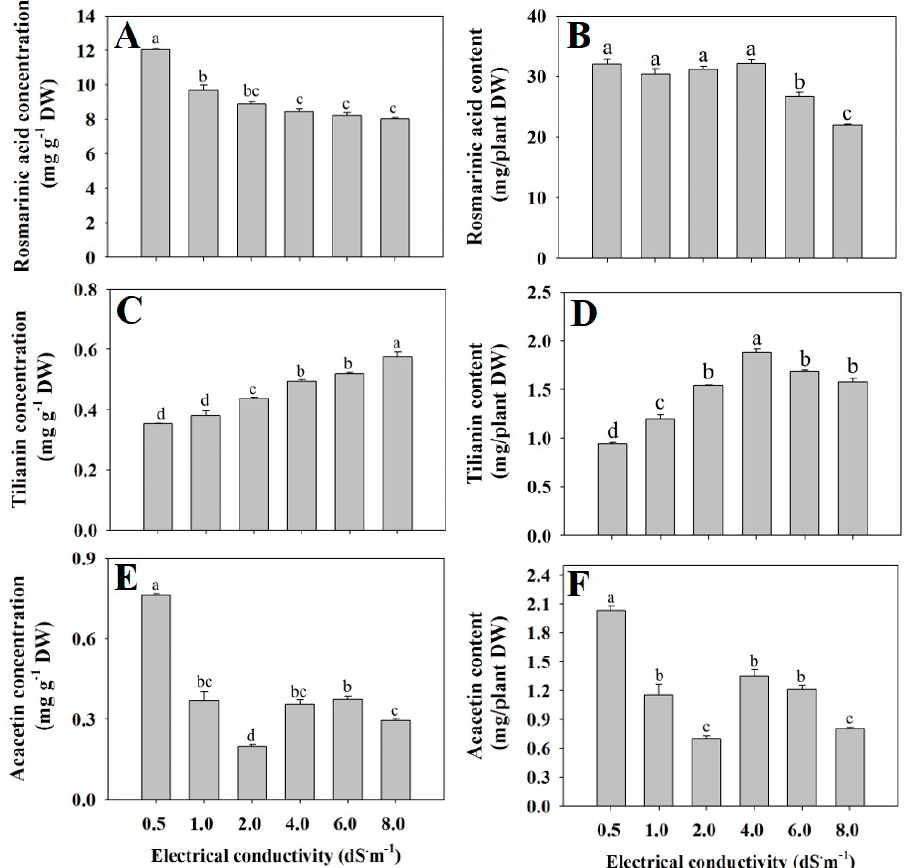
Figure 3. Rosmarinic acid ( A , B ), tilianin ( C , D ), and acacetin ( E , F ) concentrations and contents of A. rugosa at different electrical conductivity (EC) treatments (0.5, 1.0, 2.0, 4.0, 6.0, and 8.0 dS•m − 1 ). The data show the means and the vertical bars show the standard error ( n = 3). Different letters show significant differences among EC treatments (Tukey’s test, p ≤ 0.05).